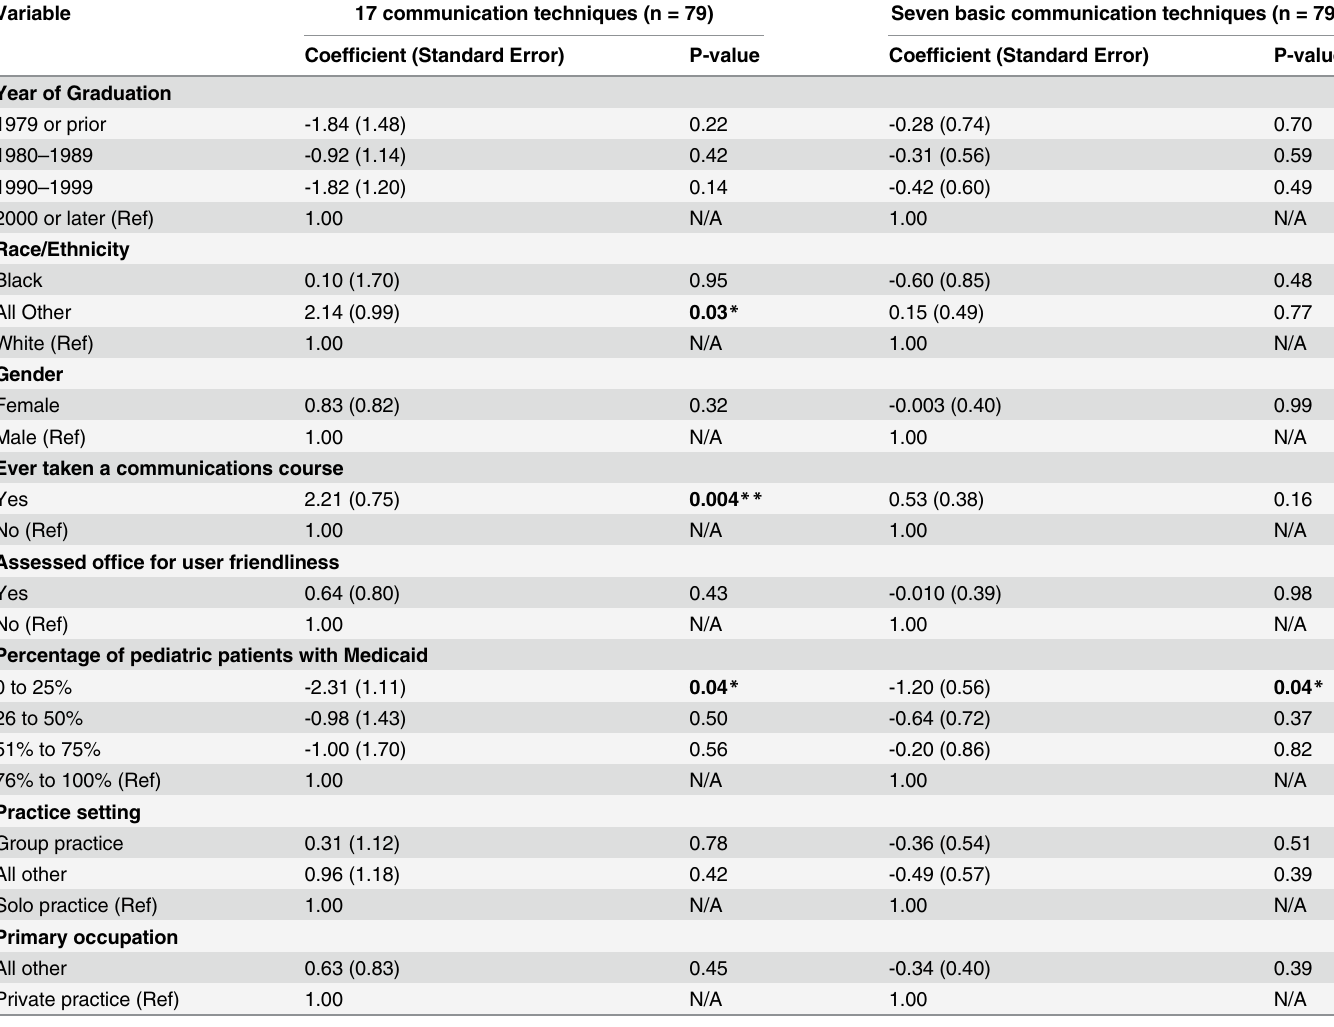
Table 7. Ordinary least squares regression of predictor variables on number of communication techniques used by family